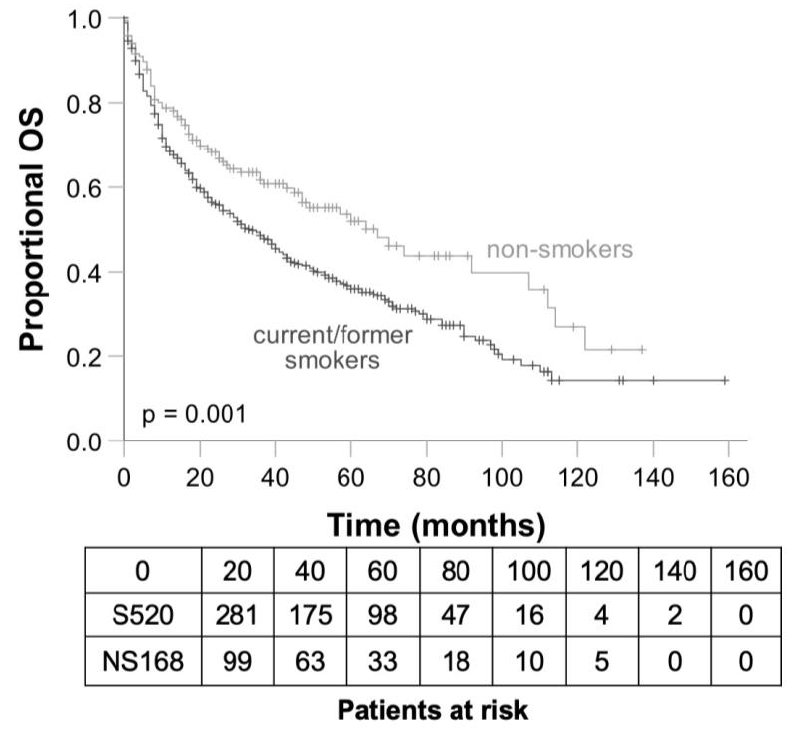
Figure 2. Overall survival depending on the smoking status. OS, overall survival; S, current/former smokers; NS, non-smokers.